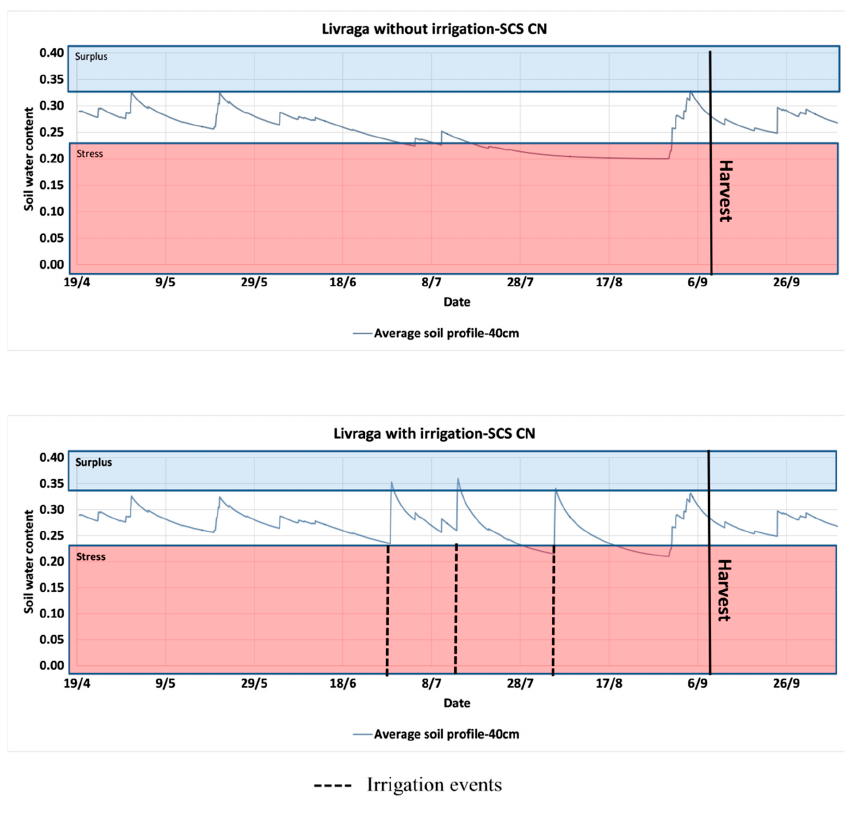
Figure 6. Soil moisture simulations of 2012 growing season in Livraga using SCS-CN for 40 cm soil profile. Water 2018 , 10 , x FOR PEER REVIEW